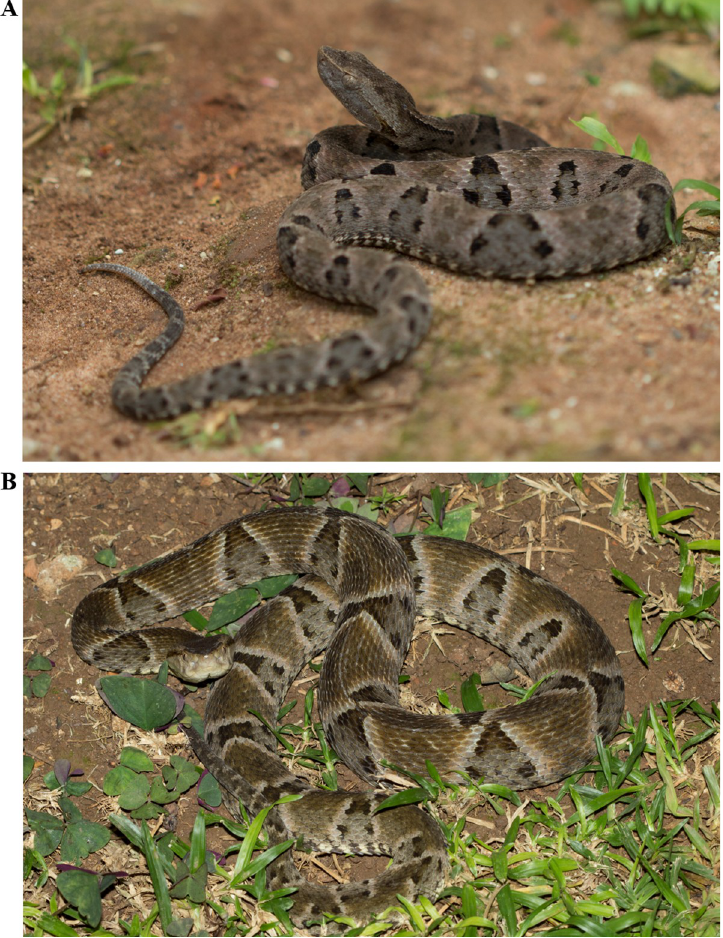
Fig 1. Juvenile and adult Bothrops moojeni . Specimens of B . moojeni snake at juvenile (A) and adult (B) stages. Photos by Sa´vio Stefanini Sant’Anna.